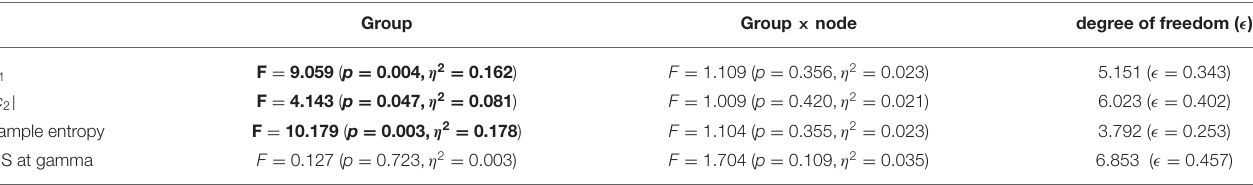
F and p values with p < 0.05 are represented by bold characters. Degree of freedom and Greenhouse-Geisser adjustments ǫ in the interaction for group × node are also shown.